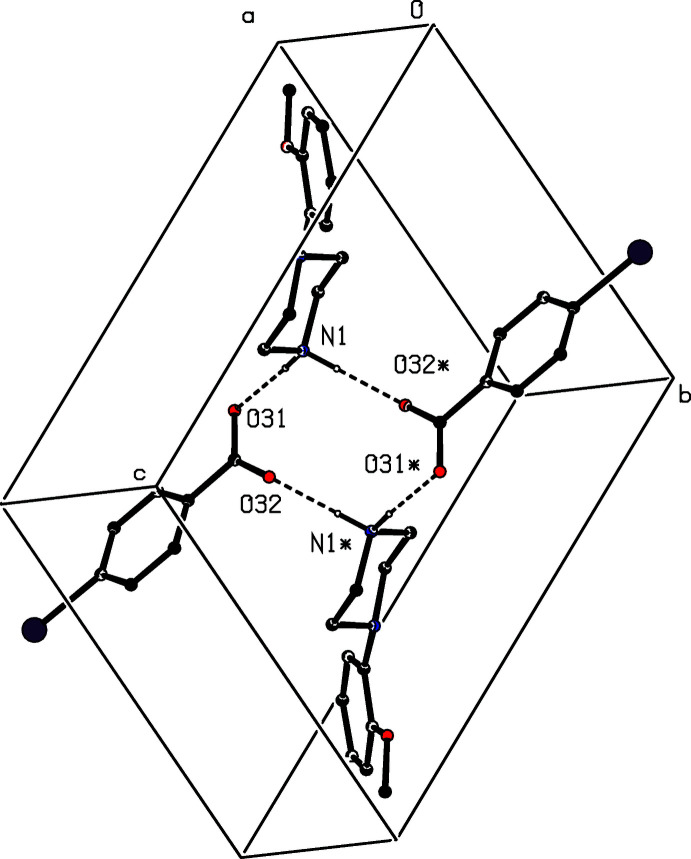
Part of the crystal structure of compound (III) showing the formation of a centrosymmetric four-ion aggregate. Hydrogen bonds are drawn as dashed lines and, for the sake of clarity, the H atoms bonded to C atoms have been omitted. The atoms marked with an asterisk (*) are at the symmetry position (1 − x, 1 − y, 1 − z).